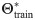
Predictive power.Red departments indicate a good prediction: the event (0 = absent, 1 = introduced or 2 = established) which was predicted with the highest probability is the event which actually occurred. Blue departments indicate an incorrect prediction: the event which was predicted with the highest probability is not the event which actually occurred. The model parameters Θtrain* (2D/1D model) and Θ˜train (2D model) were computed by maximum-likelihood estimation, based on the data of the training period 2004–2012.